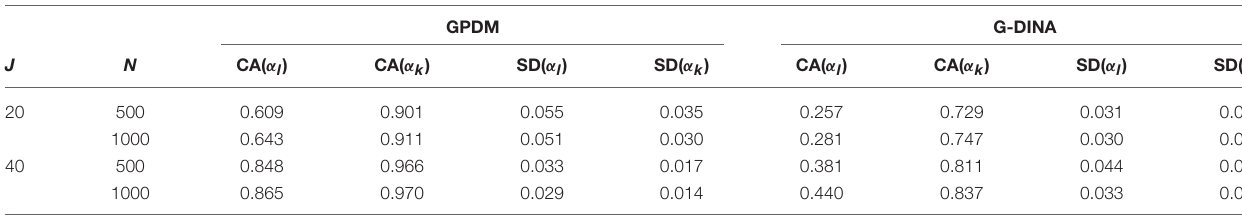
For α k , the values are averaged across all individual attributes.